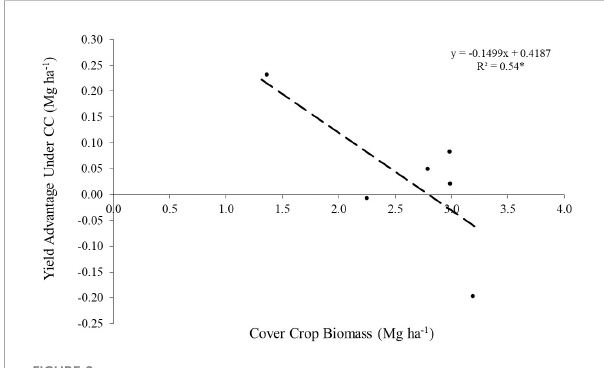
FIGURE 8 A fi gure depicting signi fi cant negative correlation between cover crop biomass (Mg ha -1 ) and yield advantage (Mg ha -1 ) under cover cropping.